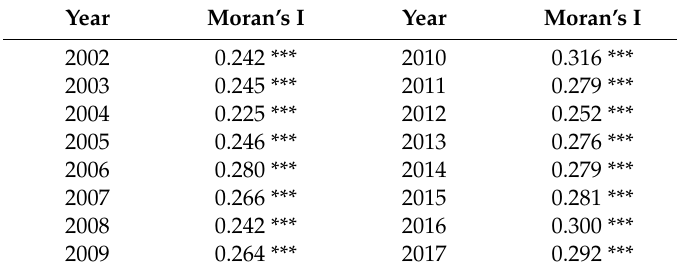
Table 3. Global Moran’s I values of PM 2.5 pollution over the YRD during the period 2002-2017.